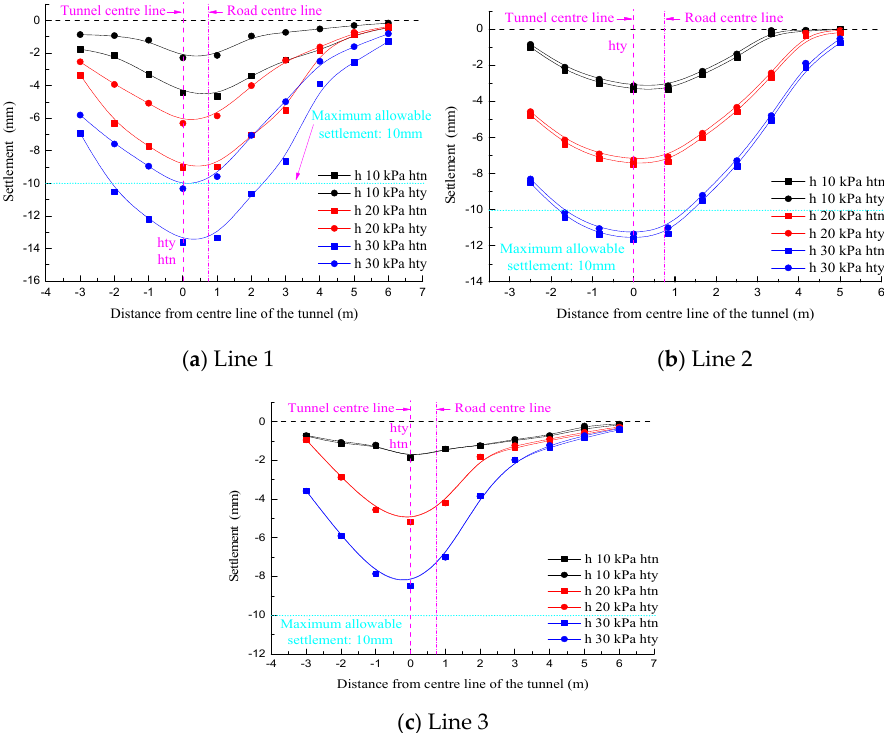
Figure 18. Longitudinal surface settlement of model H-H with D/W = 0.251.